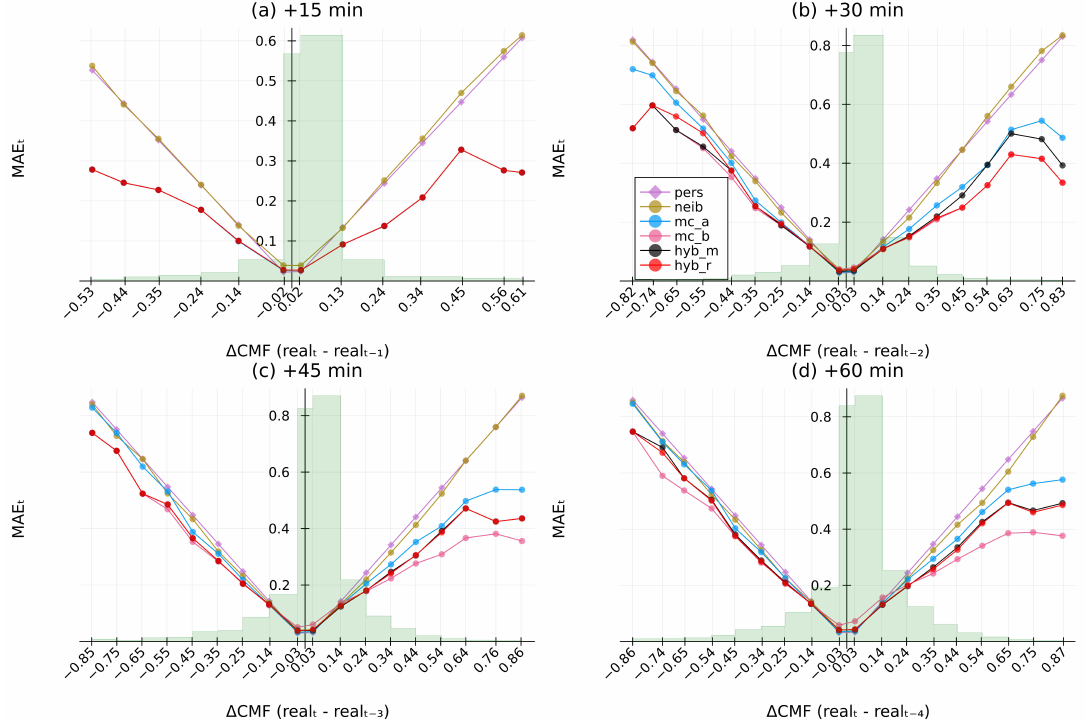
Figure A8. MAE of CMF change for ( a ) 15 min, ( b ) 30 min, ( c ) 45 min, and ( d ) 60 min ahead for